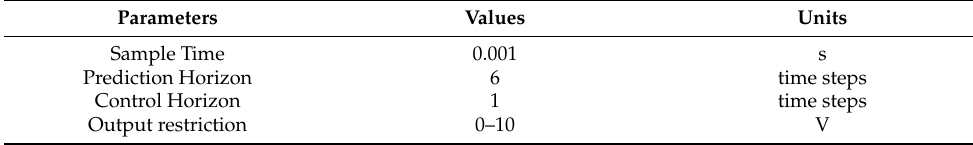
Table 2. MPC controller’s design parameters.